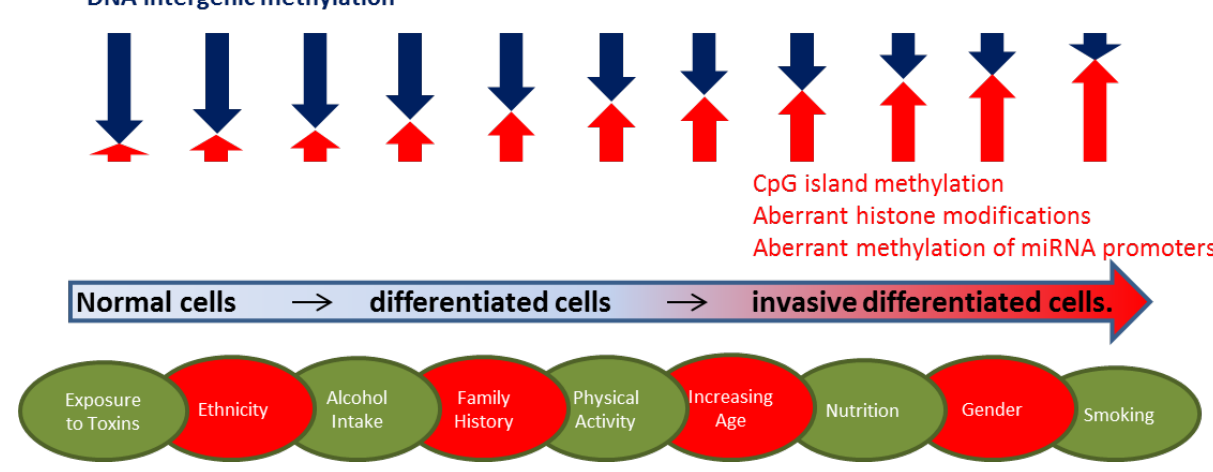
Figure 1. A diagrammatic representation of the extent and type of epigenetic modifications that promote cancer risk and/or progression, and the modifiable (in green ovals) and non-modifiable (in red ovals) factors that may influence these epigenetic